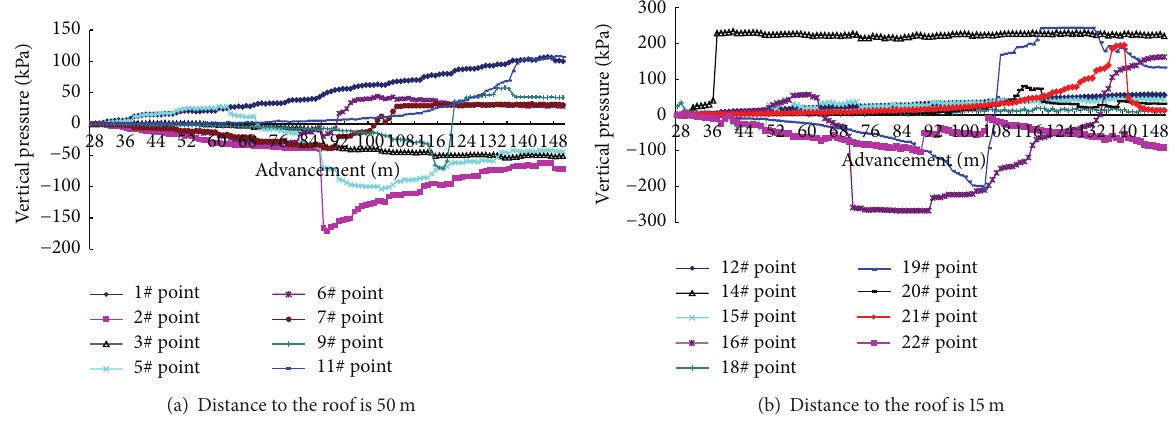
Figure 7: Vertical stress variation along with face